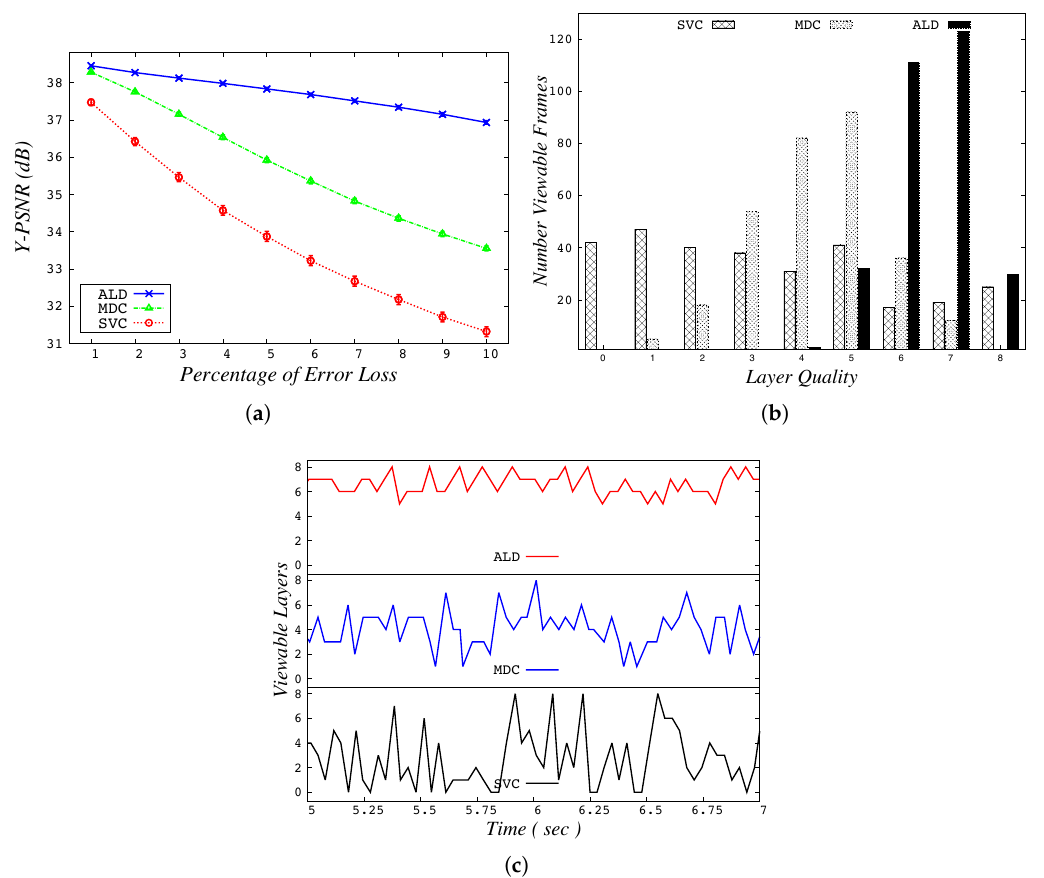
Figure 13. Performance of scalable video encoding over lossy links. ( a ) versus packet loss ratio; ( b ) viewable video quality at 10% loss; ( c ) 2 s sample of viewable quality